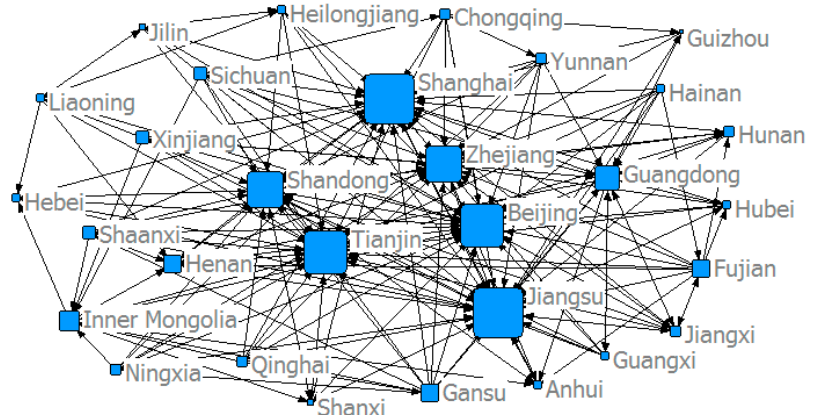
Figure 7. The structure of the ANTCE in 2013.